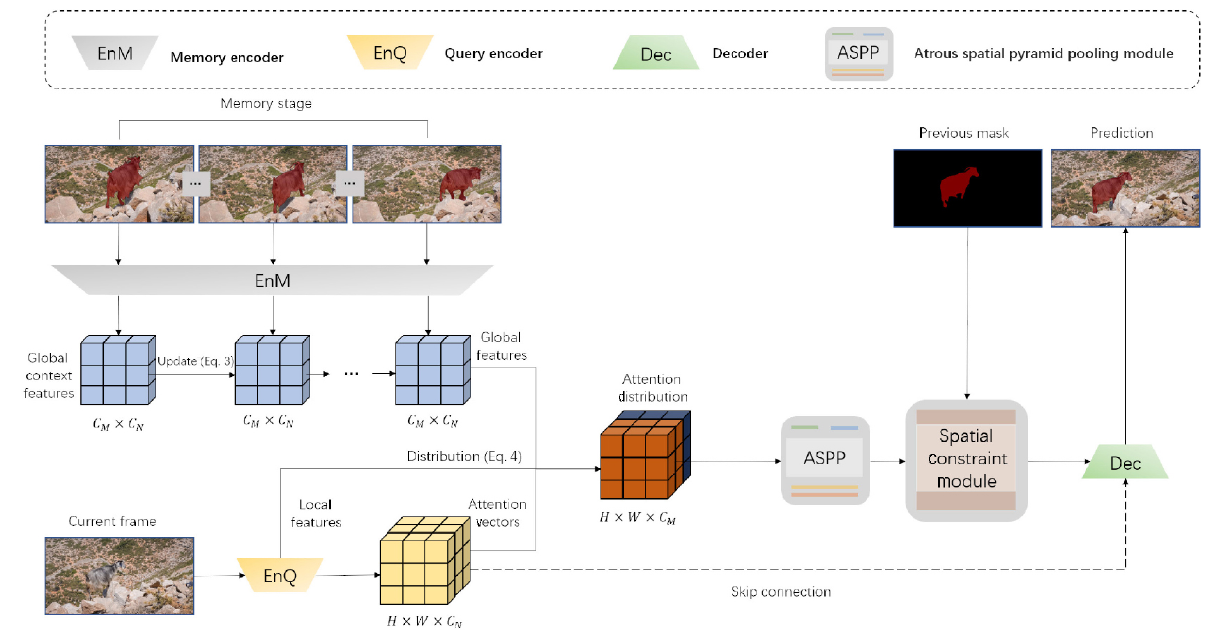
Fig. 2 Pipeline. Past frames are input into the network for encoding and sent to a fixed-size global context module. The module’s content is updated automatically as frames advance. The encoder generates a set of attention vectors for the current frame to retrieve relevant information in the global context, to form global features. The encoder also generates local features. The global and local features are concatenated and passed to the constraint module, whose result is passed to the decoder to produce the segmentation result for the